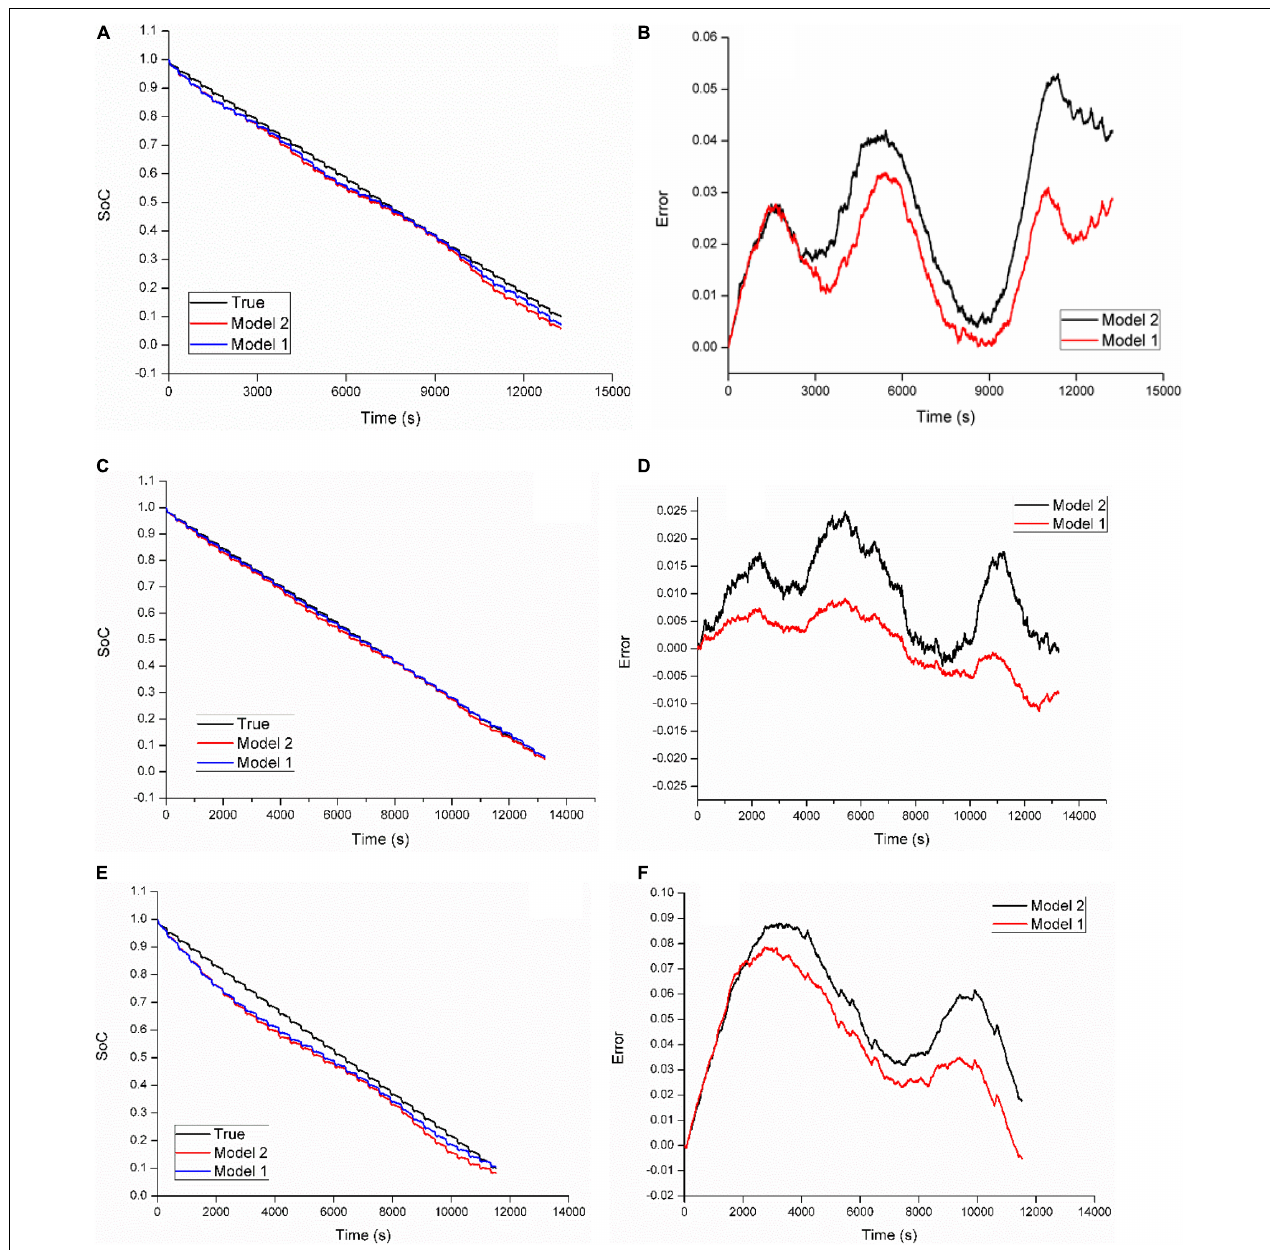
FIGURE 6 | Estimation results based on model 1 and model 2 at three temperatures via the DST. (A) Estimated SoCs at 40 ◦ C; (B) estimation errors at 40 ◦ C; (C) estimated SoCs at 22 ◦ C; (D) estimation errors at 22 ◦ C; (E) estimated SoCs at 0 ◦ C; (F) estimation errors at 0 ◦